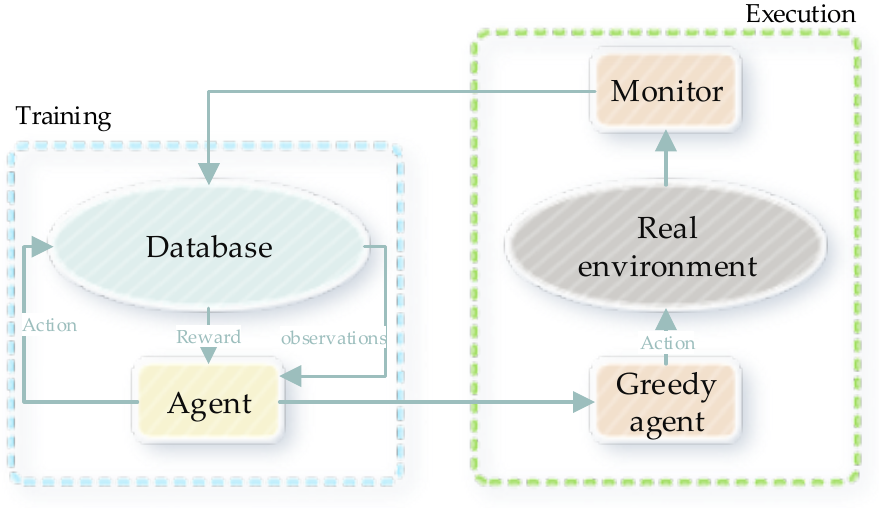
Figure 2. Deep reinforcement learning framework in smart home optimization and decision